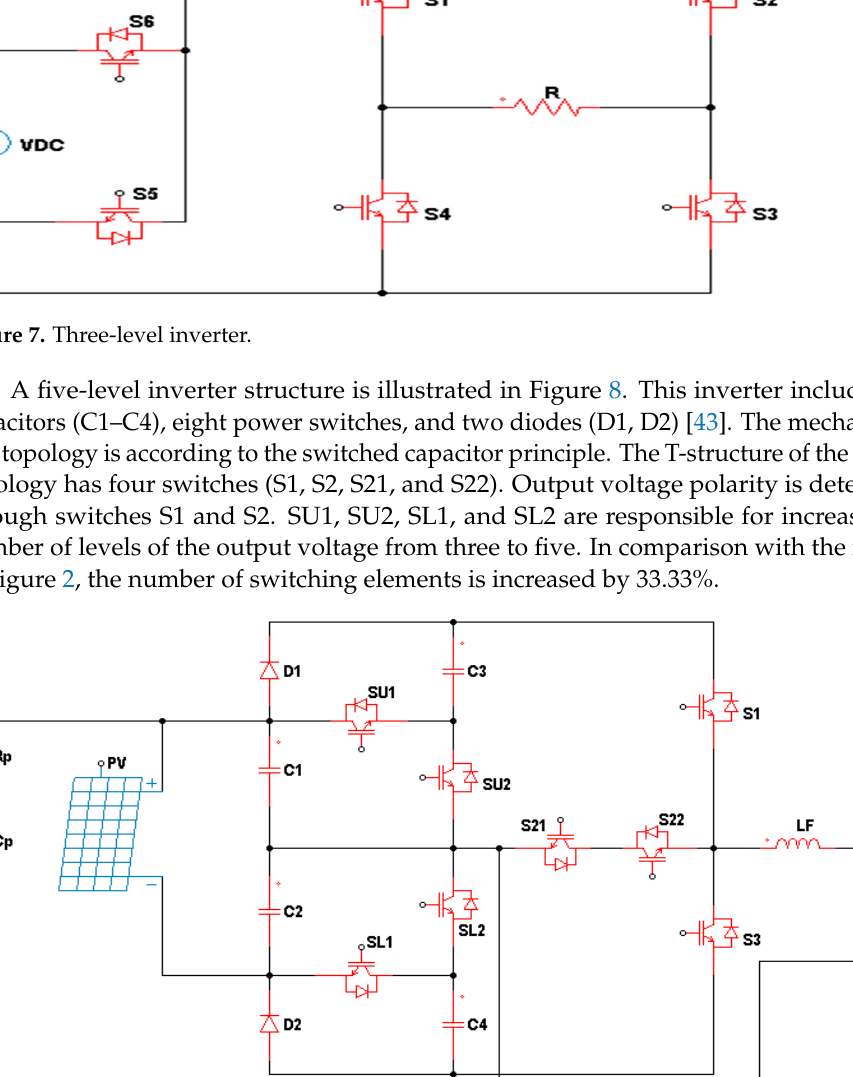
Figure 9. Modified T-MLI , ( a ) the proposed module, and ( b ) a five-level version. 3.2. Complex Designs Normally, the complex designs of T-MLIs are accompanied with an increase in the number of levels of the MLI output voltage to more than seven. Generally, most of the simple topologies of Section 3.1 can be maximized as nine-level inverters or even more levels [44]. A nine-level inverter is proposed in [45] and shown in Figure 10. It is based on